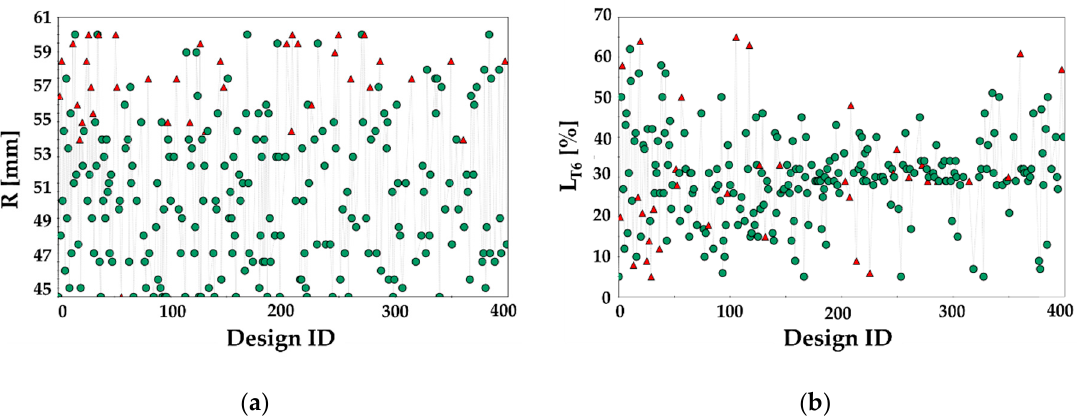
Figure 21. Results of the optimization procedure. History chart of the input parameter ( a ) R and ( b ) L T6 .